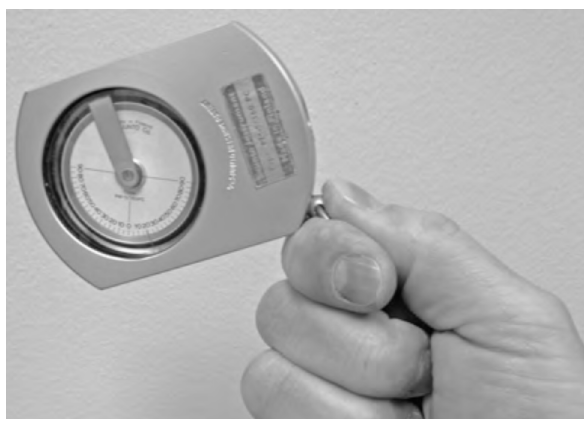
Figure 1. Suunto PM-5 analogue forestry clinometer. While the Suunto and most similar instruments are robust and relatively simple to use, they are analogue instruments that have some disadvantages for aerial surveys. These include: